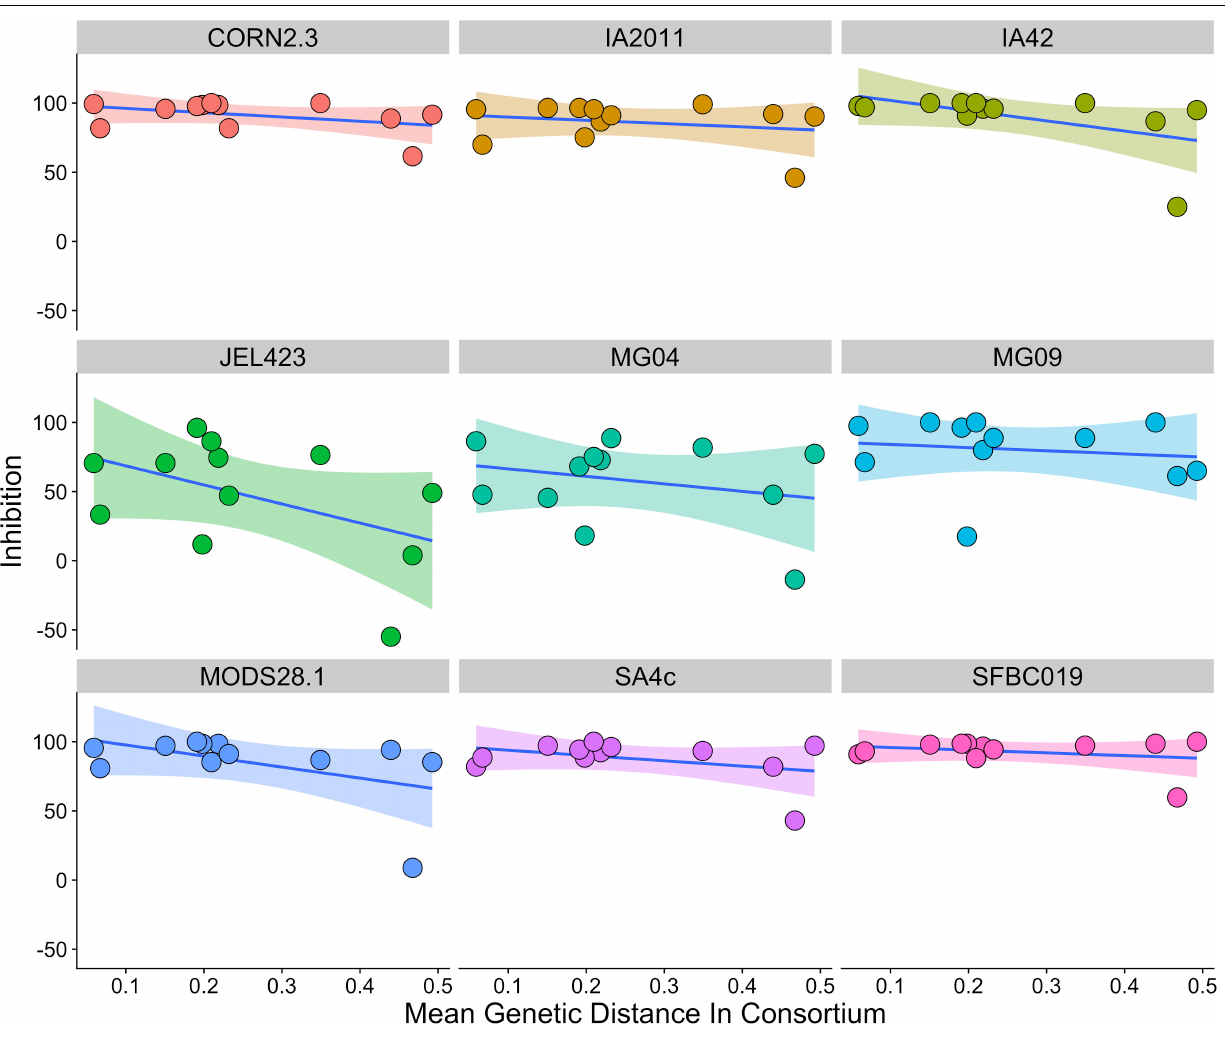
FIGURE 4 | Relationship between average genetic distance of members of a multi-isolate probiotic (2 isolates or more) and inhibition of Bd , split by Bd isolate identity. There was no evidence of a relationship between genetic distance and inhibition when controlling for probiotic ID, bacterial genus and Bd isolate identity. A linear trend line is provided for